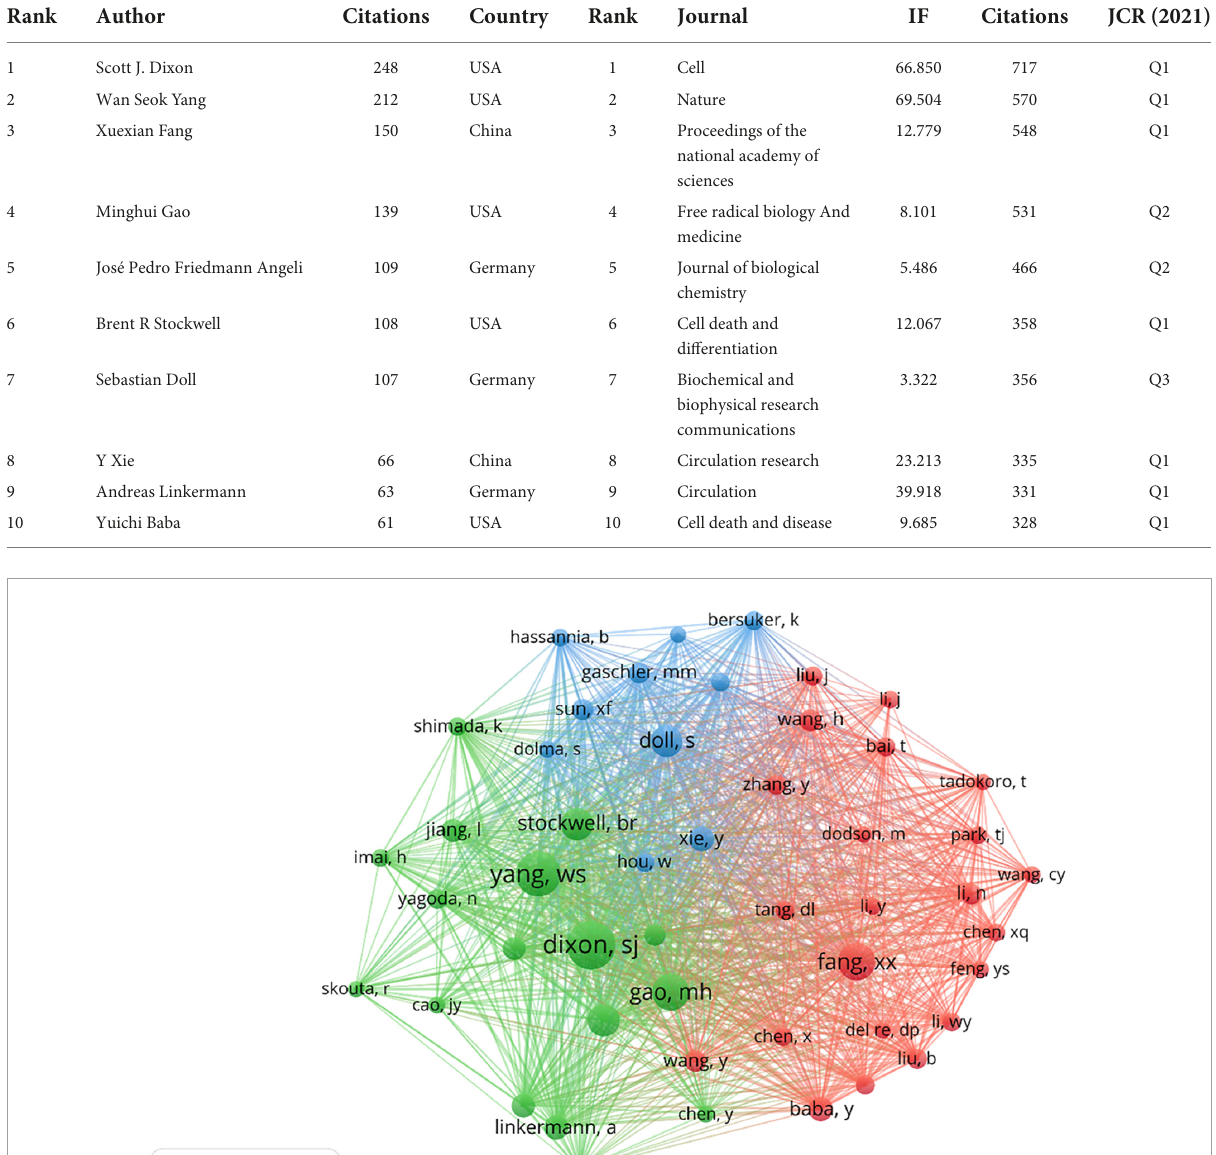
TABLE 5 Information of top 10 co-cited authors and journals.